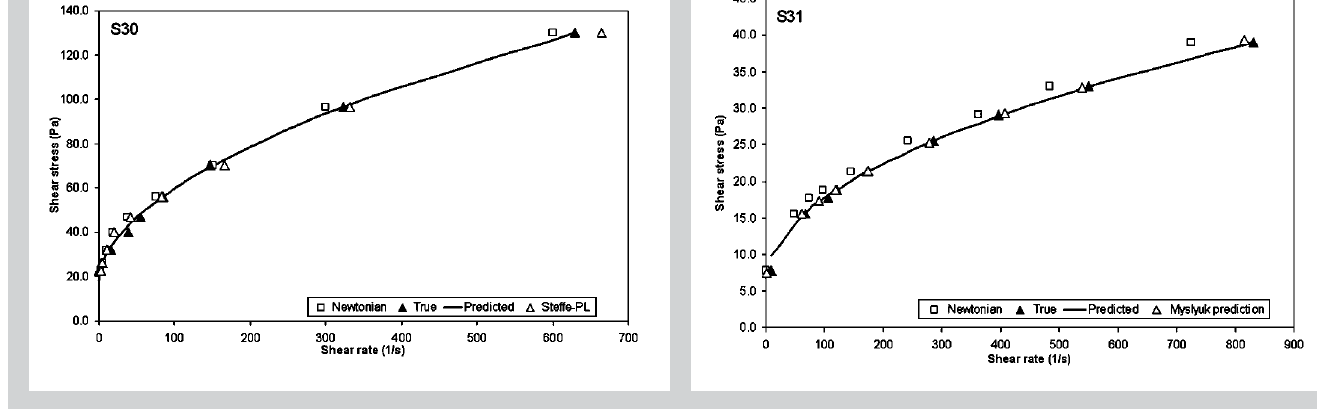
Figure 7 (left): Comparison of shear rate versus shear stress for a tomato ketchup as given by Steffe's power law approxi- mation (Steffe-PL [49]), the new approach (True)) and Newtonian equation (New- tonian). The predicted val- ues by the new approach ('prediction') are also shown as the solid line (Data: 25ºC,